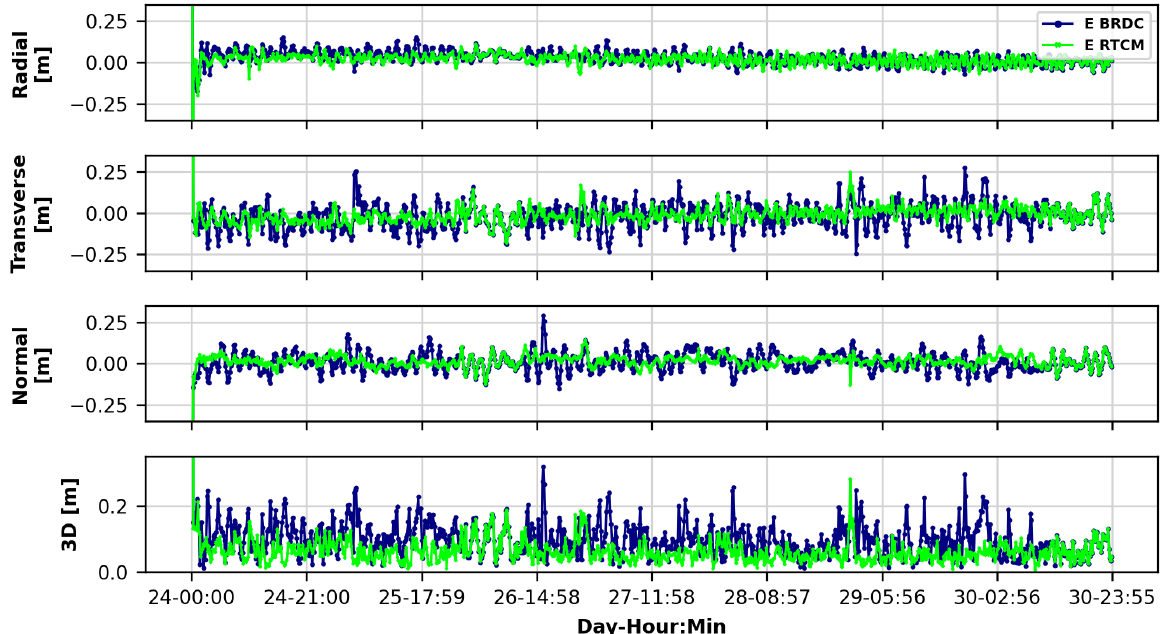
Figure 3. S6A orbital position difference with respect to CNES-POD reference solution from 24 September to 30 September 2021. Two solutions are compared: one is obtained using only broadcast navigation data (blue-colored lines), and the other is found by correcting the broadcast navigation data using RTCM corrections from CNES (green-colored lines).